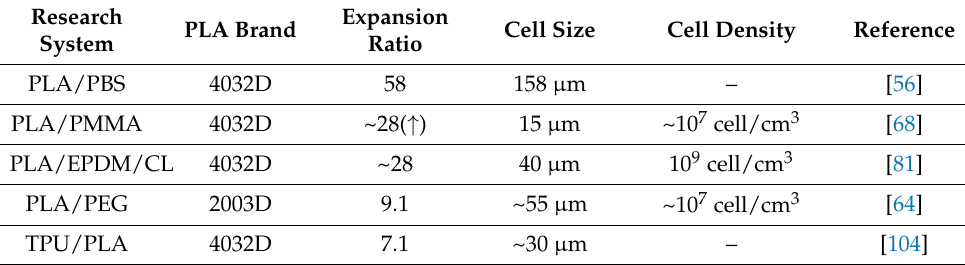
Table 4. Study on blending modification of PLA foam in recent three years.